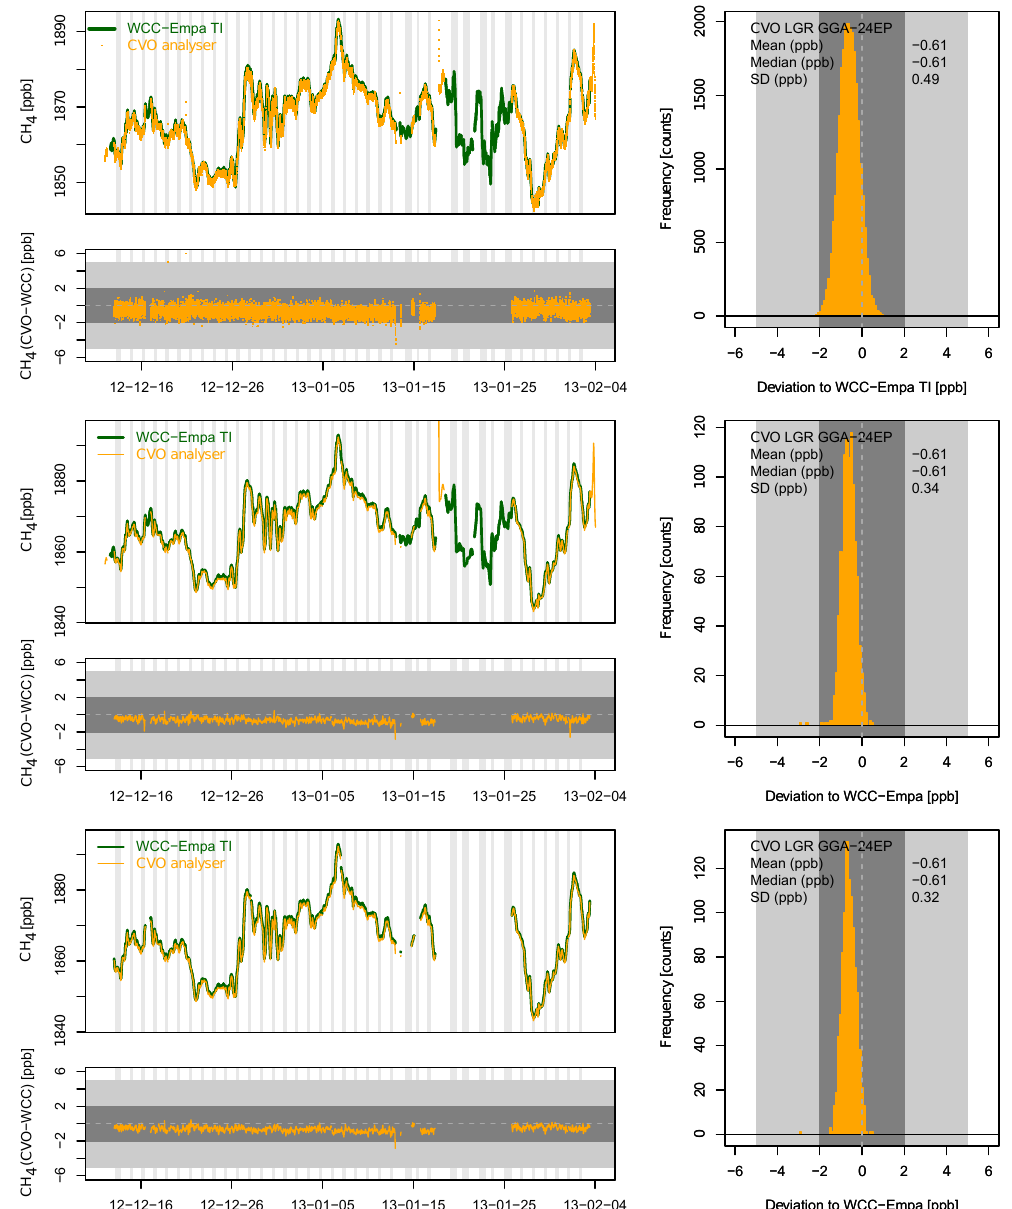
Figure 11. CH 4 comparison at CVO between the WCC-Empa travelling instrument and the CVO LGR GGA-24EP instruments. Left: CH 4 time series and CH 4 bias vs. time. Right: deviation histogram. Upper set: 1min data; middle set: 1h data, calculated from all available 1min values; lower set: 1h data, calculated from 1min values with both CVO and WCC-Empa data coverage. The grey areas correspond to the WMO/GAW compatibility (dark grey) and extended compatibility (light grey) goals; vertical grey bars illustrate when different inlets were used (see text for